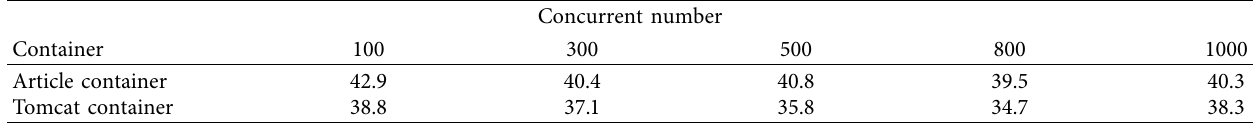
Table 2: Throughput comparison between article container and Tomcat.